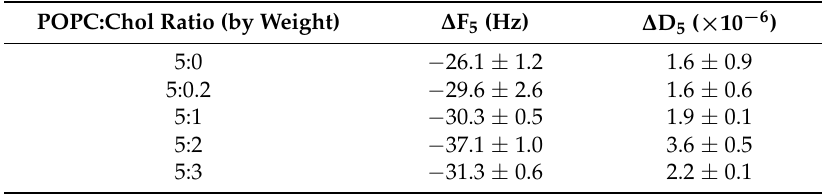
Figure 1. Determination of the liposome size and the lipid bilayer thickness as a function of different levels of cholesterol content in the lipid membrane. ( A ) The liposomes were determined size by dynamic light scattering. The lipid bilayers were formed by liposome fusion method. After the topographic images were collected, then tip indentation experiments were carried out to determine the lipid bilayer thickness (data were collected from 40 points over the surface image of lipid bilayer). ( B ) The lipid bilayer thickness was measured from the force–distance curve. Table 1. Final ∆ F and ∆ D values for the supported lipid bilayers formed with different levels of cholesterol content in the lipid membrane.